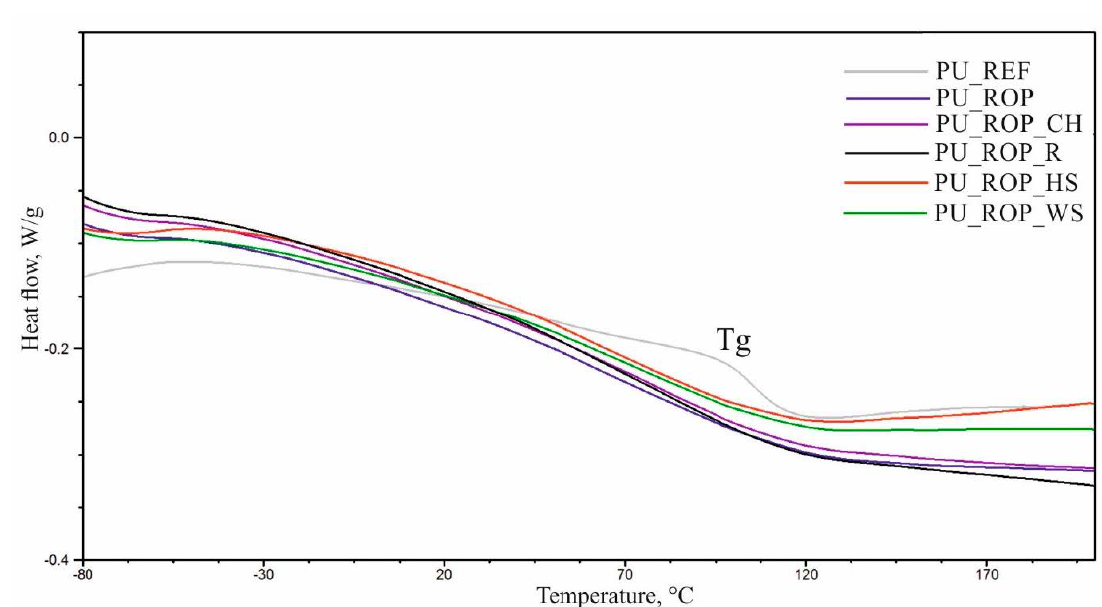
Figure 14. DSC curves (C2) of the developed